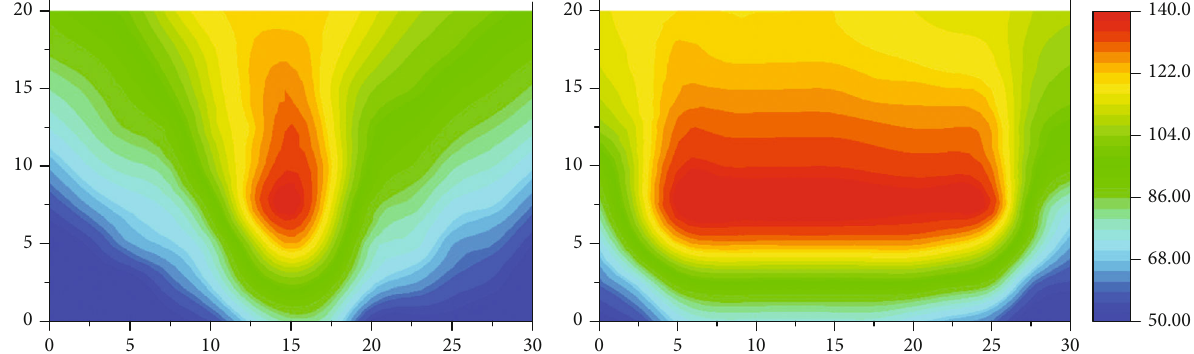
Figure 6: Temperature fi eld in the 3D model during the end stage of Experiment 1: (a) in the vertical direction of the wells and (b) along the wells.